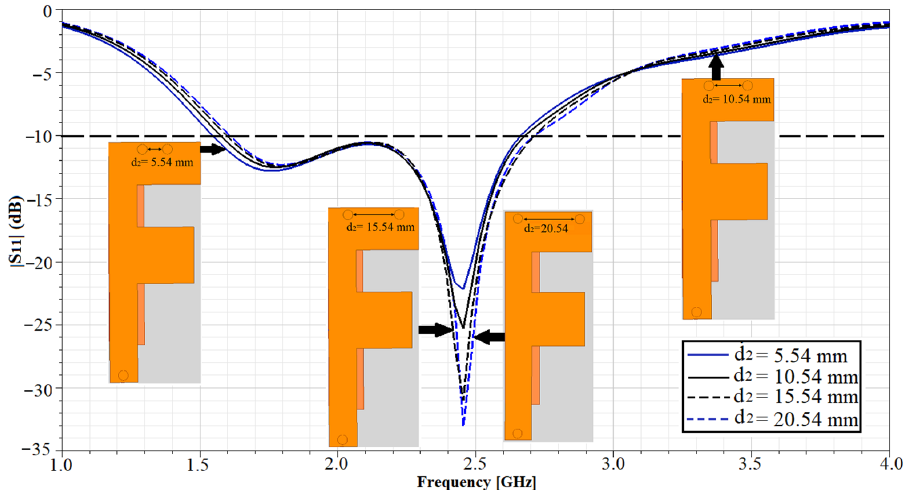
Figure 11. Variation of reflection coefficient |S 11 | with respect to the shorting pins’ positions (d 2 ).